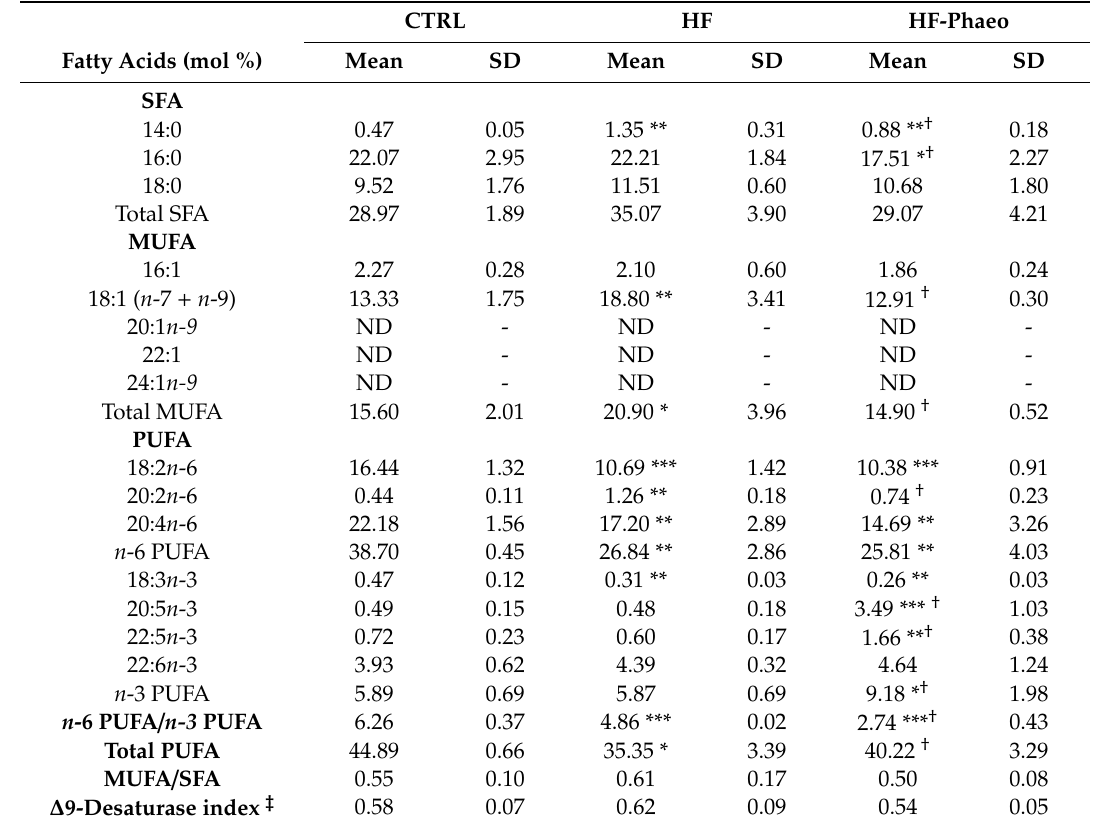
Table 2. Fatty acid composition of plasma total